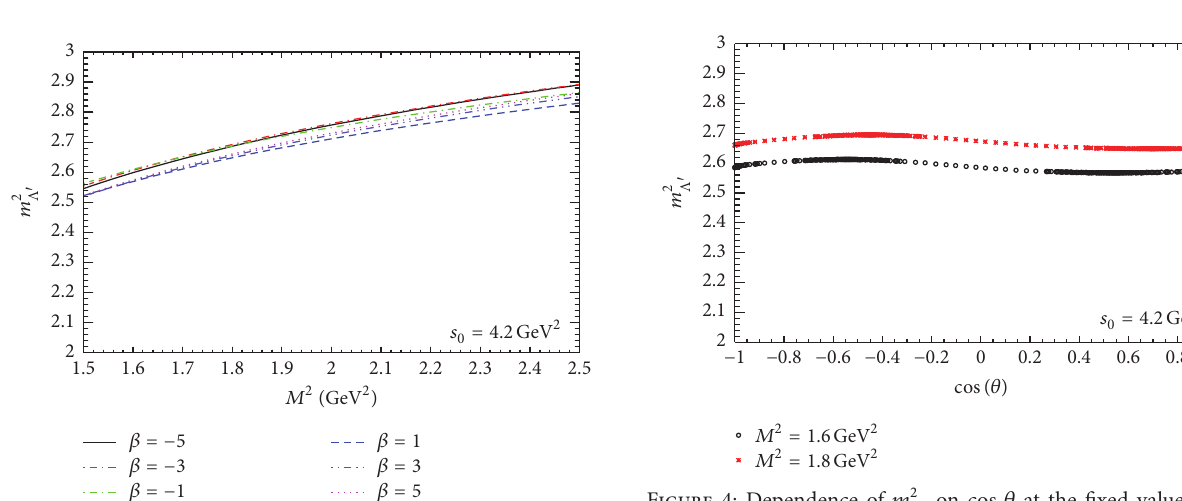
Figure 1: Dependence of 𝑚 2 𝑁 󸀠 on the Borel mass parameter 𝑀 2 for the fixed value of the continuum threshold 𝑠 0 = 3.3 GeV 2 is depicted for the several fixed values of parameter 𝛽 .